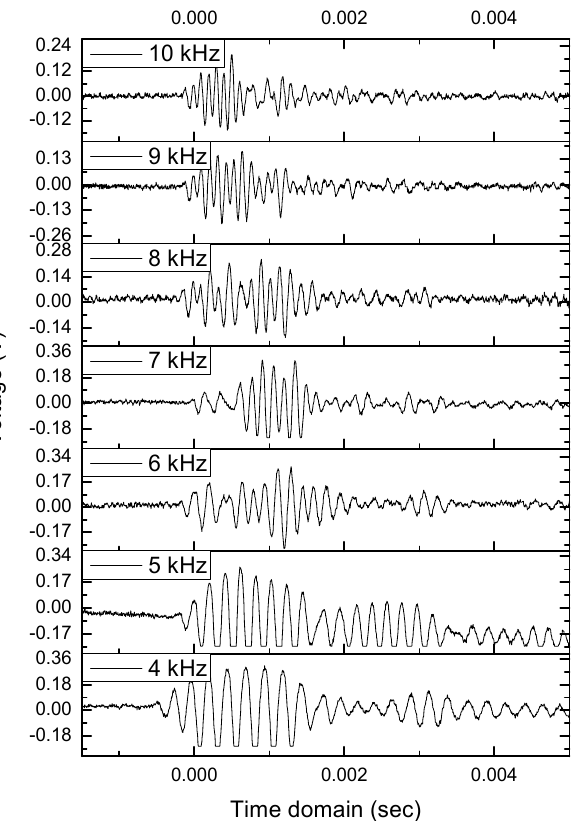
Figure 9. The electrical signals of a fiber Bragg grating hydrophone for different frequencies in the range of 4 to 10 kHz.